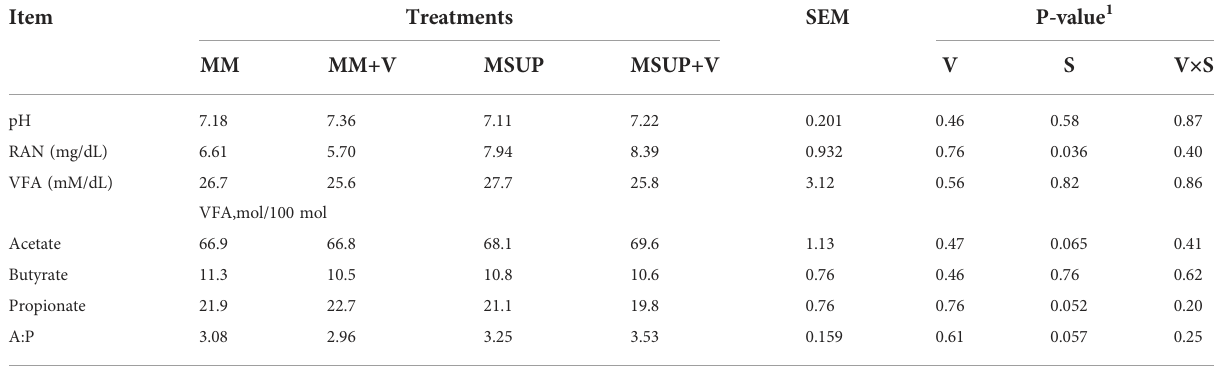
TABLE 5 Effects of feeding multiple supplement and, or virginiamycin on ruminal fermentation characteristics of Brahman heifers fed a high- quality tropical forage.